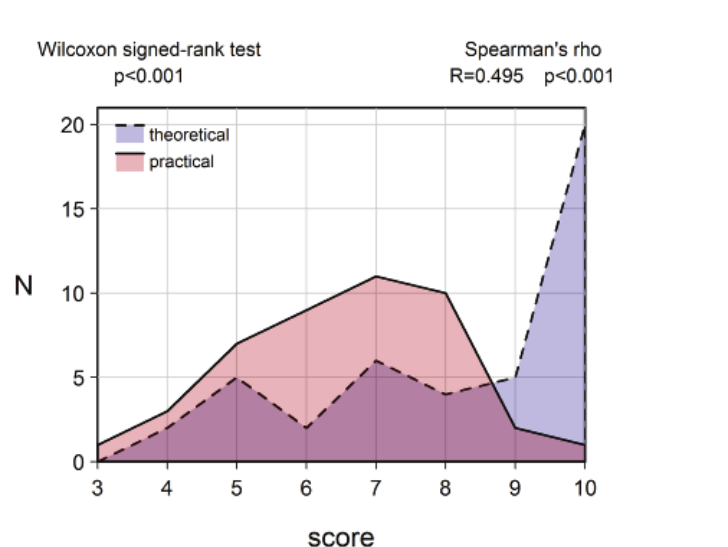
Figure 1 – Outcomes of assessing the “battle order” assignment Рис . 1 – Результаты оценивания задачи « боевой порядок » Слика 1 – Резултати оцењивања задатка " наређење за борбу